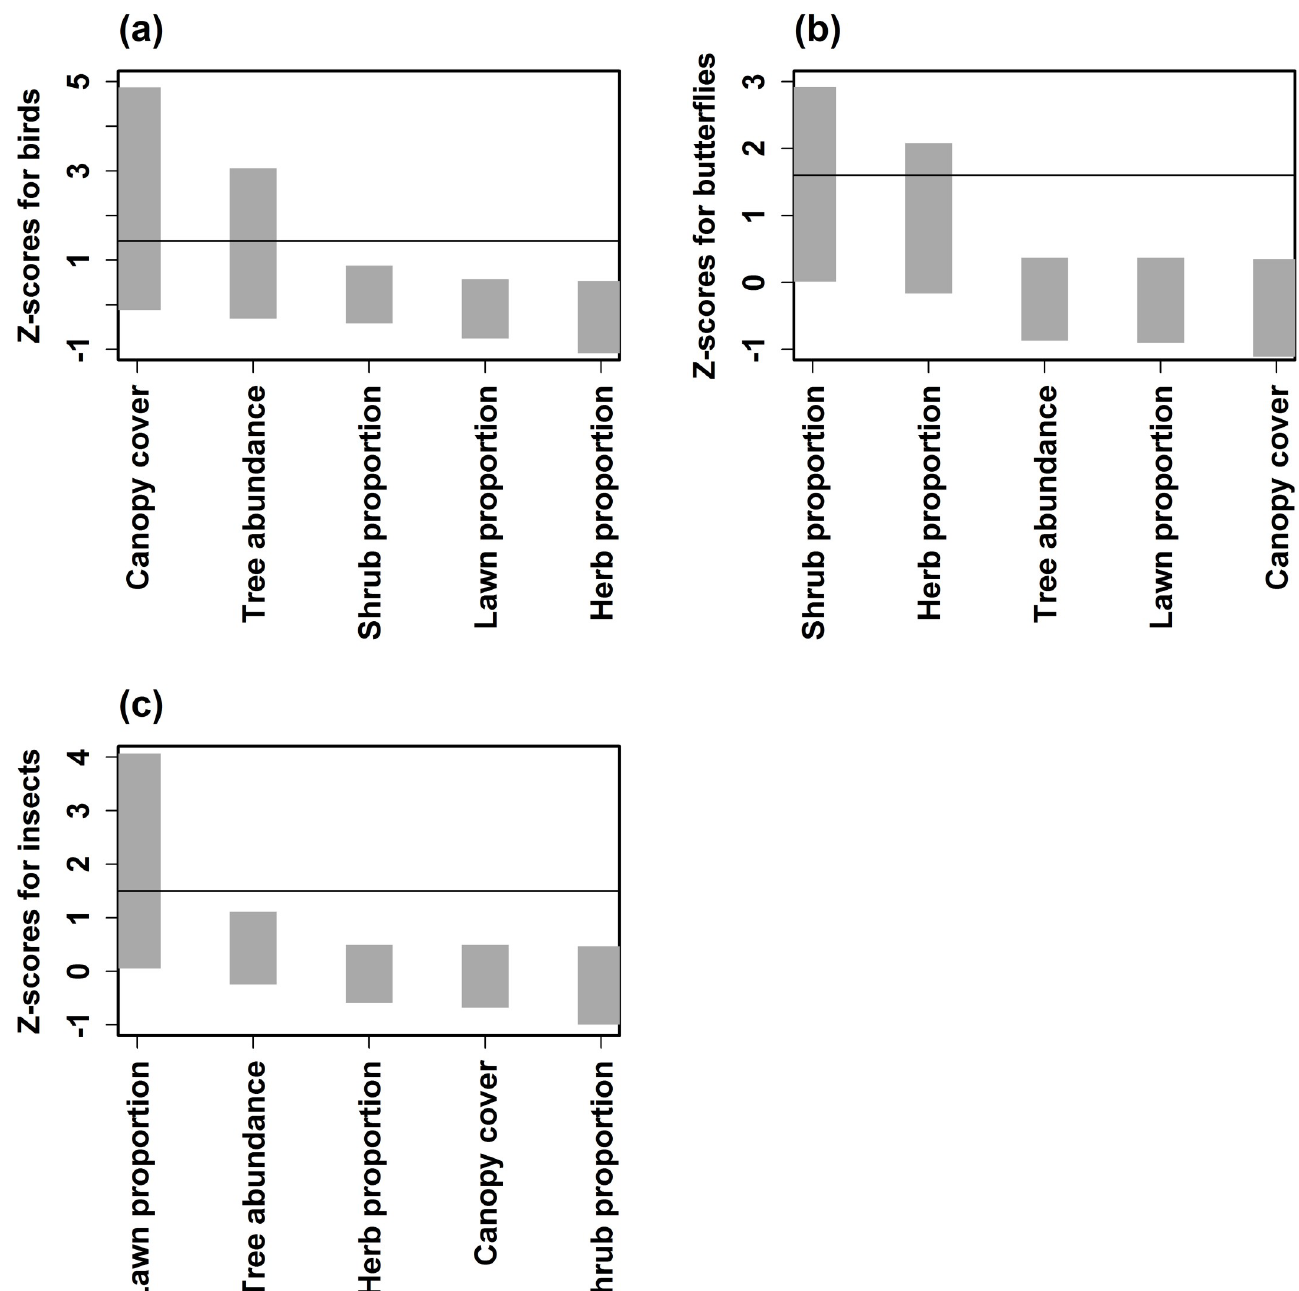
Fig 5. Hierarchical partitioning to determine variables that influence (a) Birds; (b) Butterflies and (c) Insects at park scale.